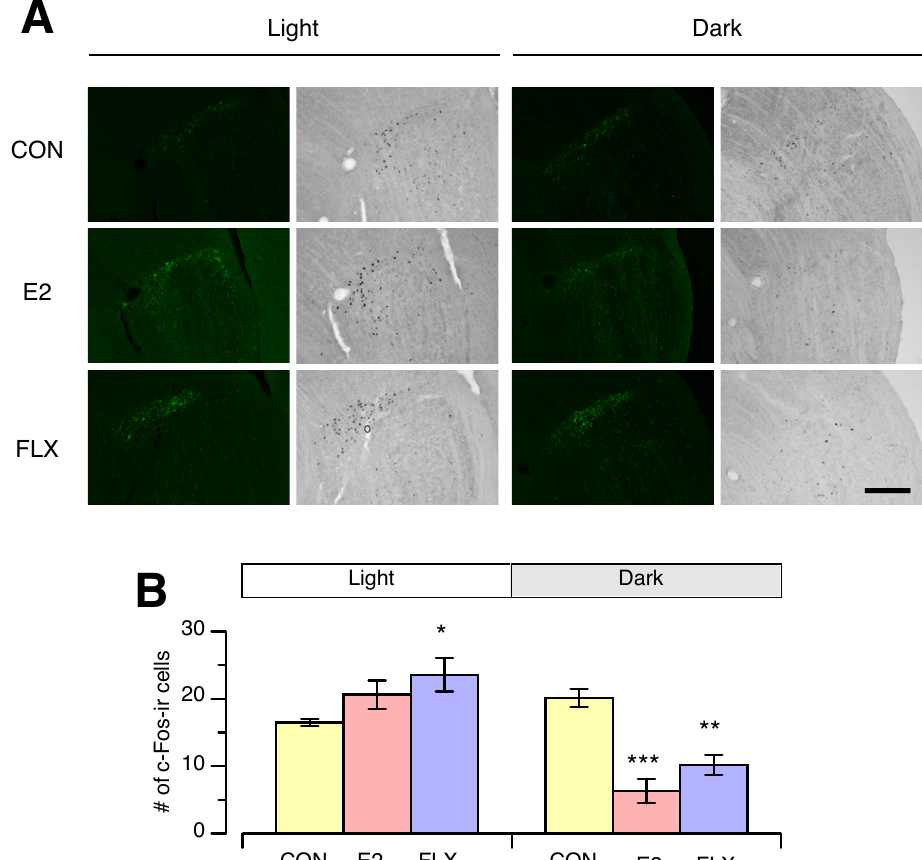
Figure 6. The e ff ect of estradiol or fluoxetine on c-Fos expression in the intergeniculate leaflet (IGL) during the light phase (ZT3-7) and dark phase (ZT15-19) in ovariectomized female rats. ( A ): Representative microscope images of c-Fos-immunoreactive (ir) nuclei and neuropeptide Y (NPY) immunoreactivity in the IGL during the light phase and dark phase. Scale bar = 200 µ m. ( B ): Number of c-Fos-ir nuclei in the IGL during the light phase and dark phase. Female rats were ovariectomized and assigned to the estradiol- or cholesterol-treated group. Six or seven days after ovariectomy, half of the cholesterol-treated rats were subcutaneouly ( s.c. ) injected twice daily with 5 mg / kg fluoxetine (FLX) at ZT0 and ZT12, while the other half of the cholesterol-treated rats (CON) and all of the E2-treated rats (E2) were s.c. injected with the same volume of saline. Samples were obtained on the 10th of FLX treatment. Data are shown as the mean ± SEM ( n = 9 in CON, n = 8 in E2, and n = 8 in FLX during the light phase; n = 5 in CON, n = 5 in E2, and n = 6 in FLX during the dark phase). Note: *, **, and ***: significant di ff erences at p < 0.05, p < 0.01 and p < 0.001, respectively, between the CON and treatment